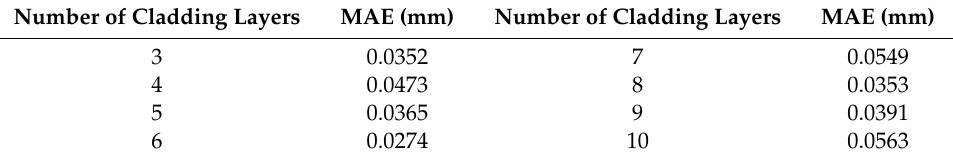
Table 9. Predicted precision of established model.